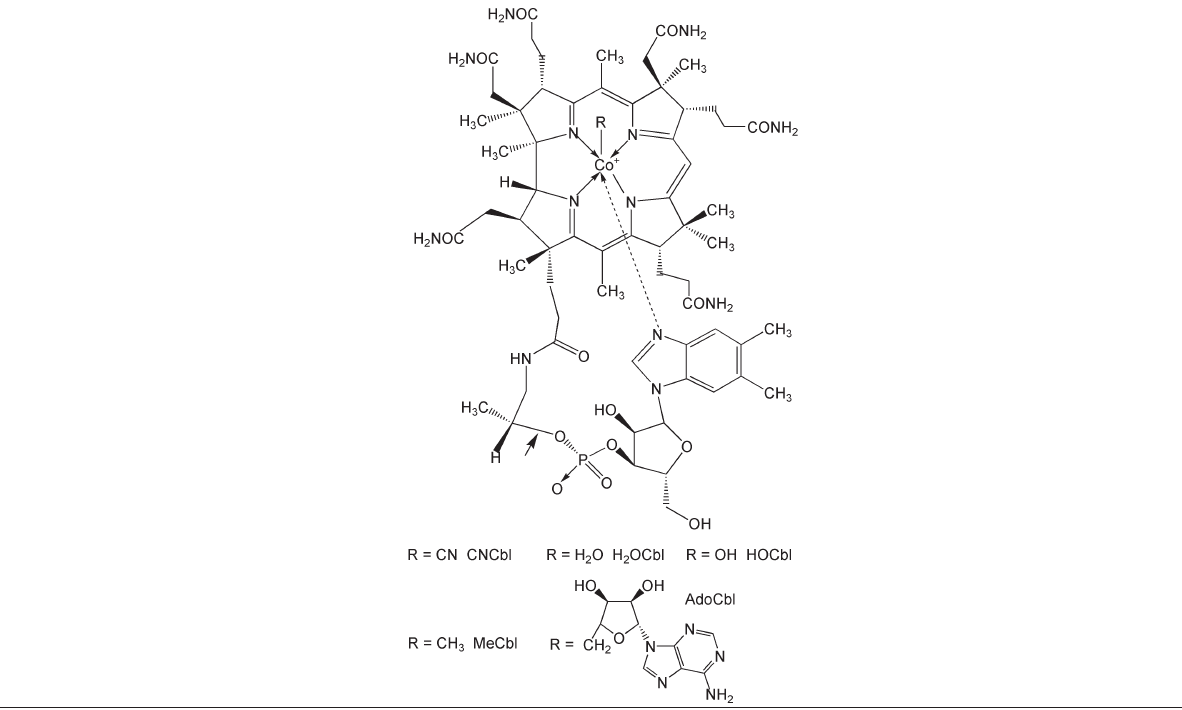
or cyanocobalamin (R=CN, CNCbl), aquocobalamin (R=H Figure 1: Structures of cobalamins. Vitamin B 12 methylcobalamin (R=CH , MeCbl) and adenosylcobalamin, also known as coenzyme B 3 in the ‘base-on’ form in which the 5,6-dimethylbenzimidazole base (dbzm) is coordinated to Co, but they can also exist in the ‘base-off’ form in which dbzm is not coordinated to Co and may be replaced by another ligand. H and both are present at physiological pH. Hydrolysis of the bond at gives the corresponding